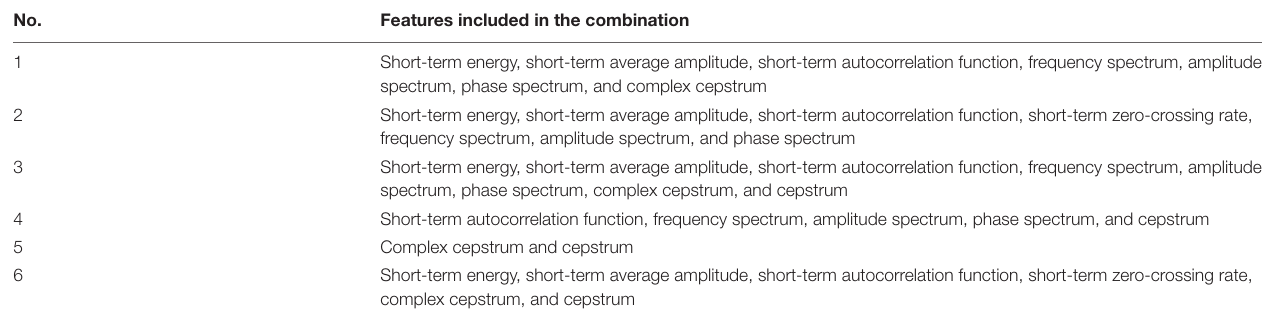
FIGURE 5 | Identification process. TABLE 1 | Details of feature